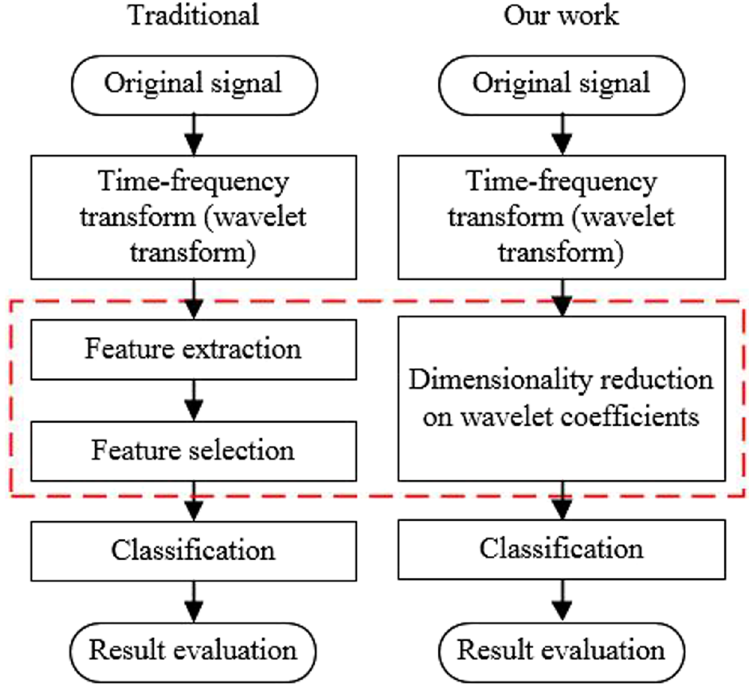
Figure 7. Comparison between our method and traditional wavelet transform-based